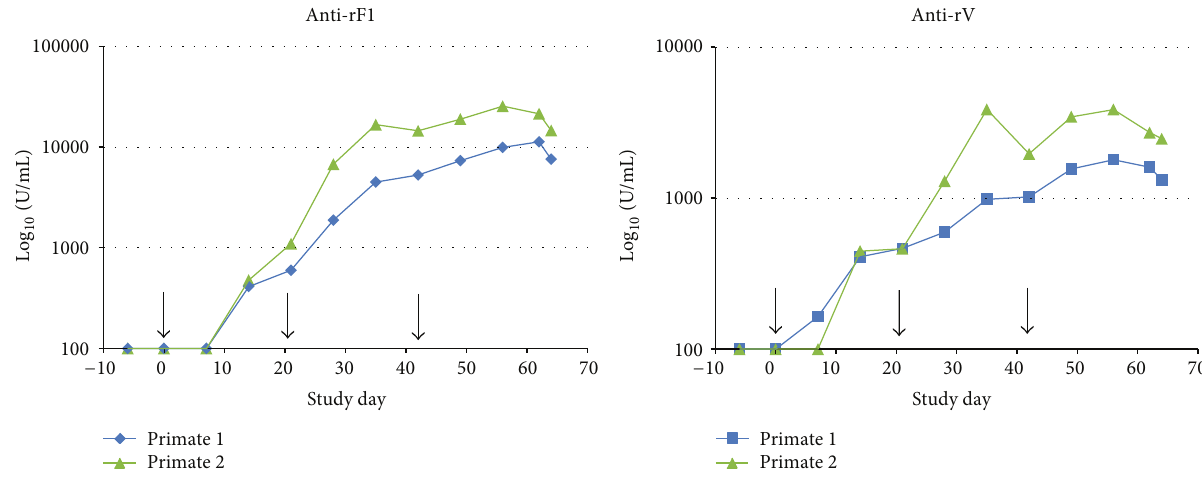
Figure 8: Assessment of anti-rF1 and anti-rV antibody titres in NHP serum after 3 intramuscular immunizations of 10 𝜇 g of rF1 and rV antigen. Detectable amounts of anti-rF1 and anti-rV antibodies were found in the serum 2 weeks after the primary immunization, with anti- rF1 consistently having a higher titre.